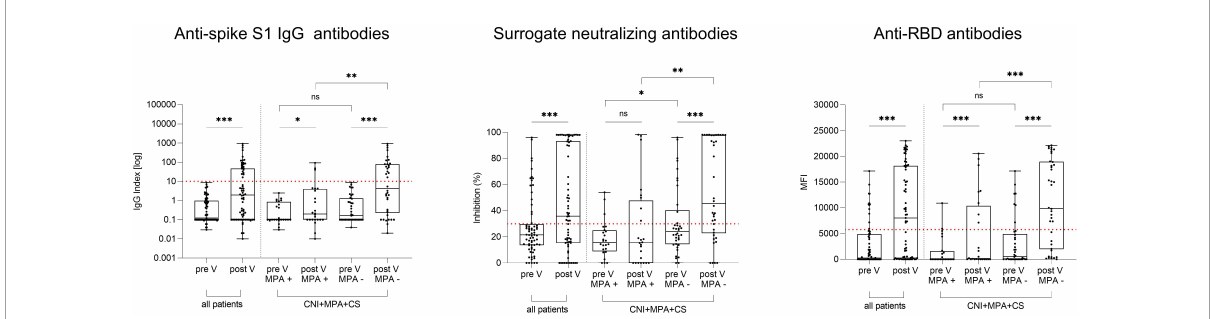
FIGURE2 Anti-spike S1 IgG, surrogate neutralizing, and anti-receptor-binding domain antibodies in 69 kidney transplant recipients before and after an additional mRNA-1273 vaccine dose. Anti-spike S1 IgG (left panel), surrogate neutralizing (middle panel) and anti-RBD (right panel) antibodies in 69 KTR before and after additional COVID-19 vaccination. Results were stratified for 62 patients with triple immunosuppressive therapy consisting of a calcineurin inhibitor (CNI), mycophenolic acid (MPA), and corticosteroids (CS) according to temporary MPA withdrawal during vaccination (MPA + vs MPA -). KTR with breakthrough infections ( N = 9) were excluded from all analyses. The dashed red line indicates the cut-off for detection of antibodies for each assay. CNI, calcineurin inhibitor; CS, corticosteroids; MFI, mean fluorescence intensity; MPA, mycophenolic acid; V, vaccination; ∗∗∗ P < 0.001; ∗∗ P < 0.01; ∗ P < 0.05; ns,